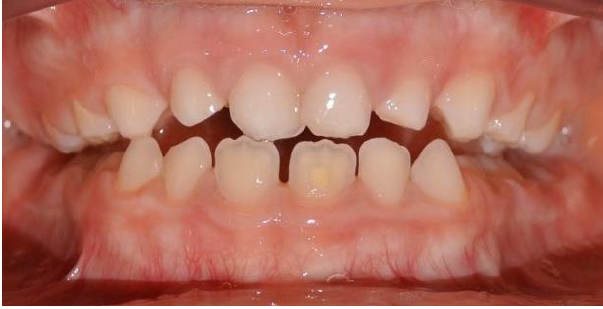
Figure 5. Intraoral frontal picture: edge-to-edge occlusion obtained after 4 months of treatment. This was a sign that the appliance was operating. After 7 months from the beginning of the therapy, the anterior crossbite was resolved. The initial negative overjet and deep bite were treated. The mandible’s functional deviation disappeared and so the lower midline deviated 2 mm on the right, the opposite side of the original deviation (Figure